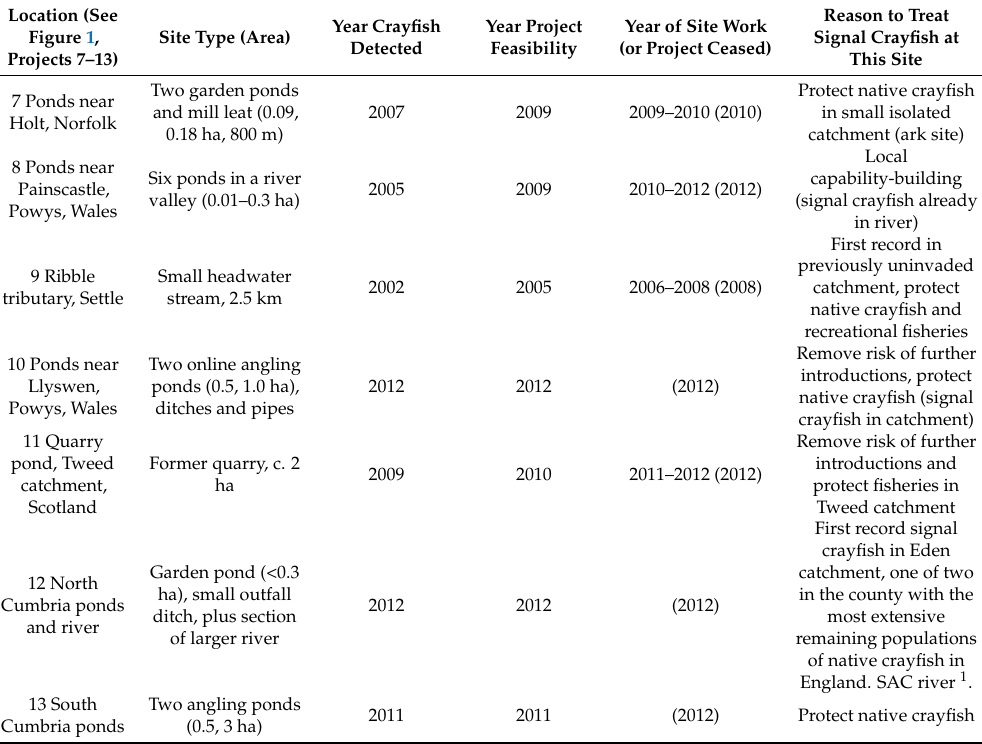
Table 2. A summary of potential biocide projects in the U.K. that did not proceed to completion. Location (See Figure 1,